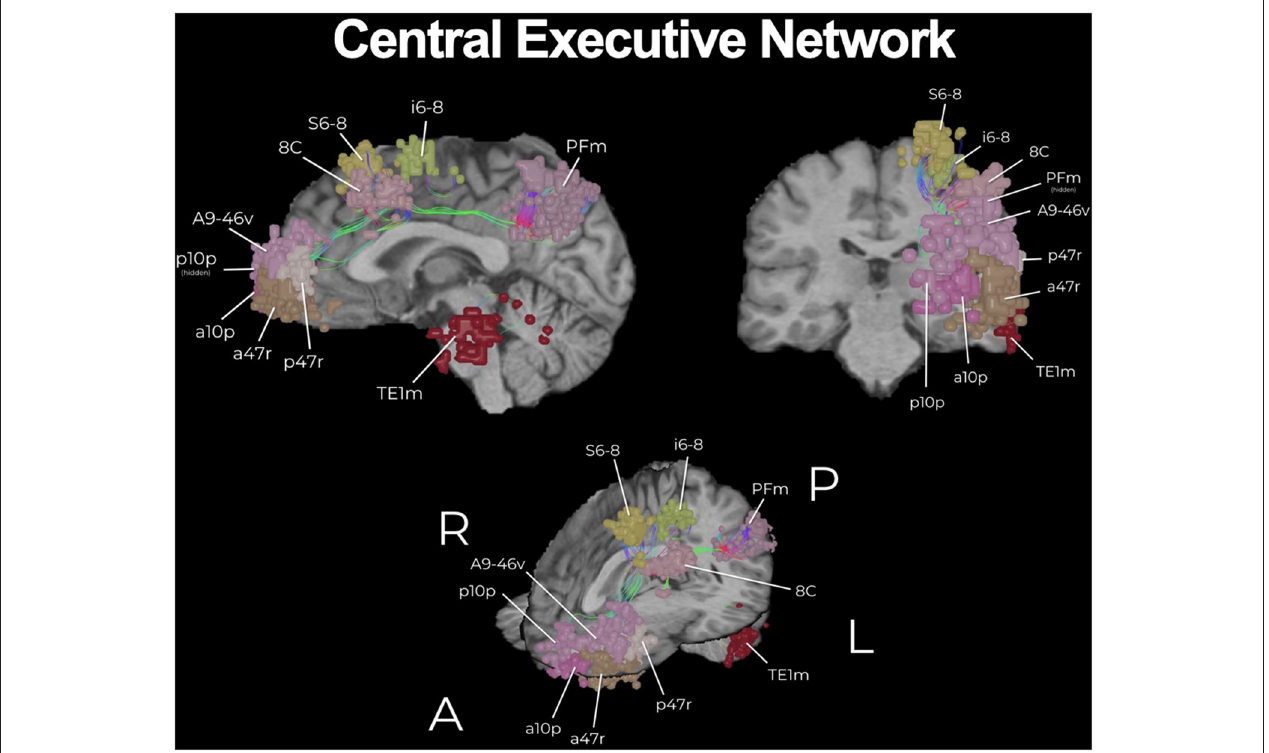
FIGURE 3 | The core of the central executive network (CEN). The CEN is a key multi-lobar control network necessary for effective cognitive functioning and its main core is provided here. Functional regions have been visualized in 3D space and therefore some parcellations have been covered or require multiple views for correct spatial understanding due to parallax. An example of this is the provided with brain parcellation area TE1m (temporal area 1 middle), which is correctly found on the lateral surface of the middle aspect of the middle temporal gyrus (83). Visualization of tracts have been minimized (thickness and volume) to maximize the visibility of